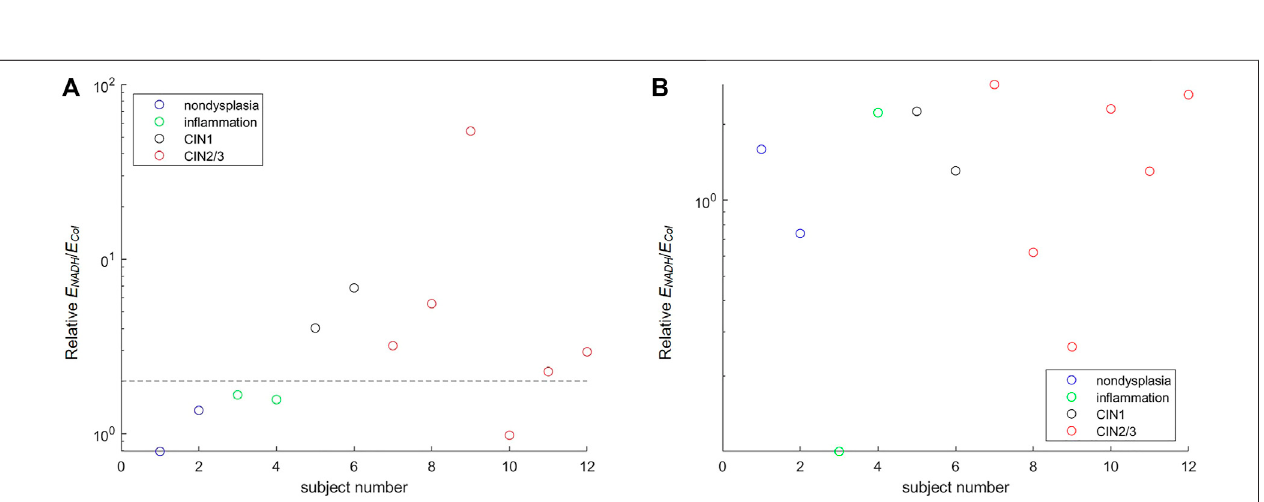
FIGURE9| RatioofNADHtocollagen fl uorescenceef fi ciencyextractedfrom in-vivo spectra.Theratioextractedfromthecolposcopicallysuspicious(biopsied)site is normalized by that from the normal site on the same subject (A) The result of the two-layer forward model with a dashed horizontal line drawn at a value of two to separate CIN from non-CIN subjects (B) The result of the one-layer forward